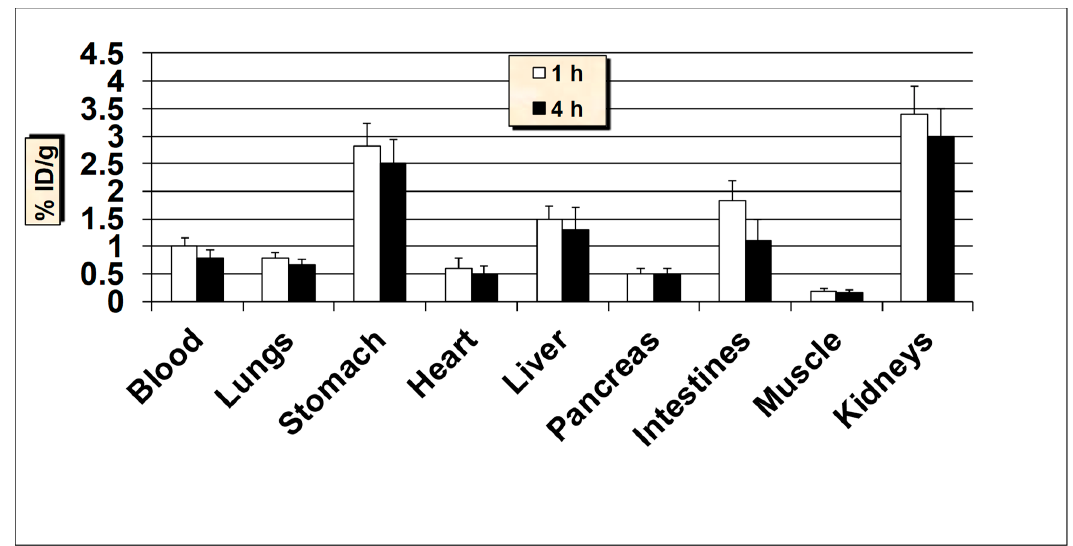
Figure 11. In vivo tissue biodistribution studies of 99m Tc-MUC1-derived peptide in normal Balb/c mice at 1 h and 4 h post-injection. Data is presented as % injected dose per gram (% ID/g) of tissue/organ (n = 3–5, mean values ± SD). Parts of the intestines were measured without their contents.